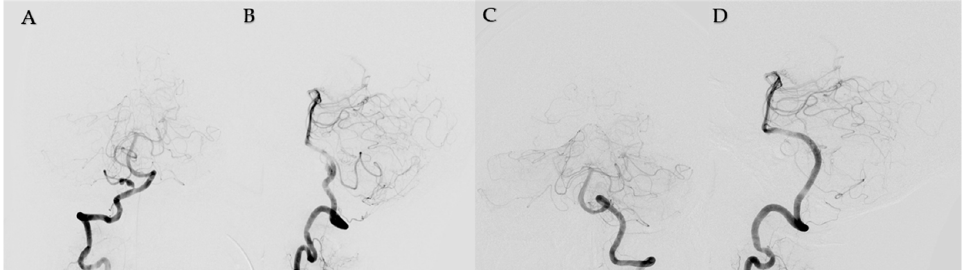
Figure 1. The right vertebral arterial angiogram ( A , B ) showed an approximately 10 mm-sized long segmental dissecting aneurysm on proximal posterior inferior cerebellar artery (PICA) and large PICA vessels with PICA dominance over the anterior inferior cerebellum artery in supply of the cerebellum. Left vertebral arterial angiogram was shown. ( C , D ).